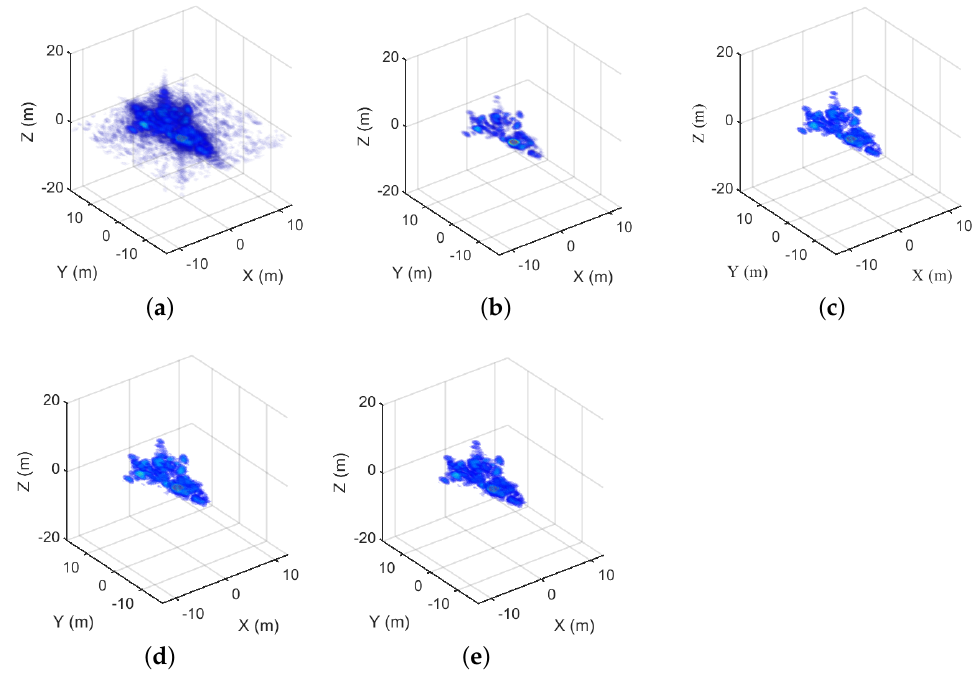
Figure 4. The imaging results of the aircraft corresponding to the 75% sampling rate. ( a ) The MF result. ( b ) The FIST result. ( c ) The SCAD result. ( d ) The MCP result. ( e ) The GSALSA–Cauchy